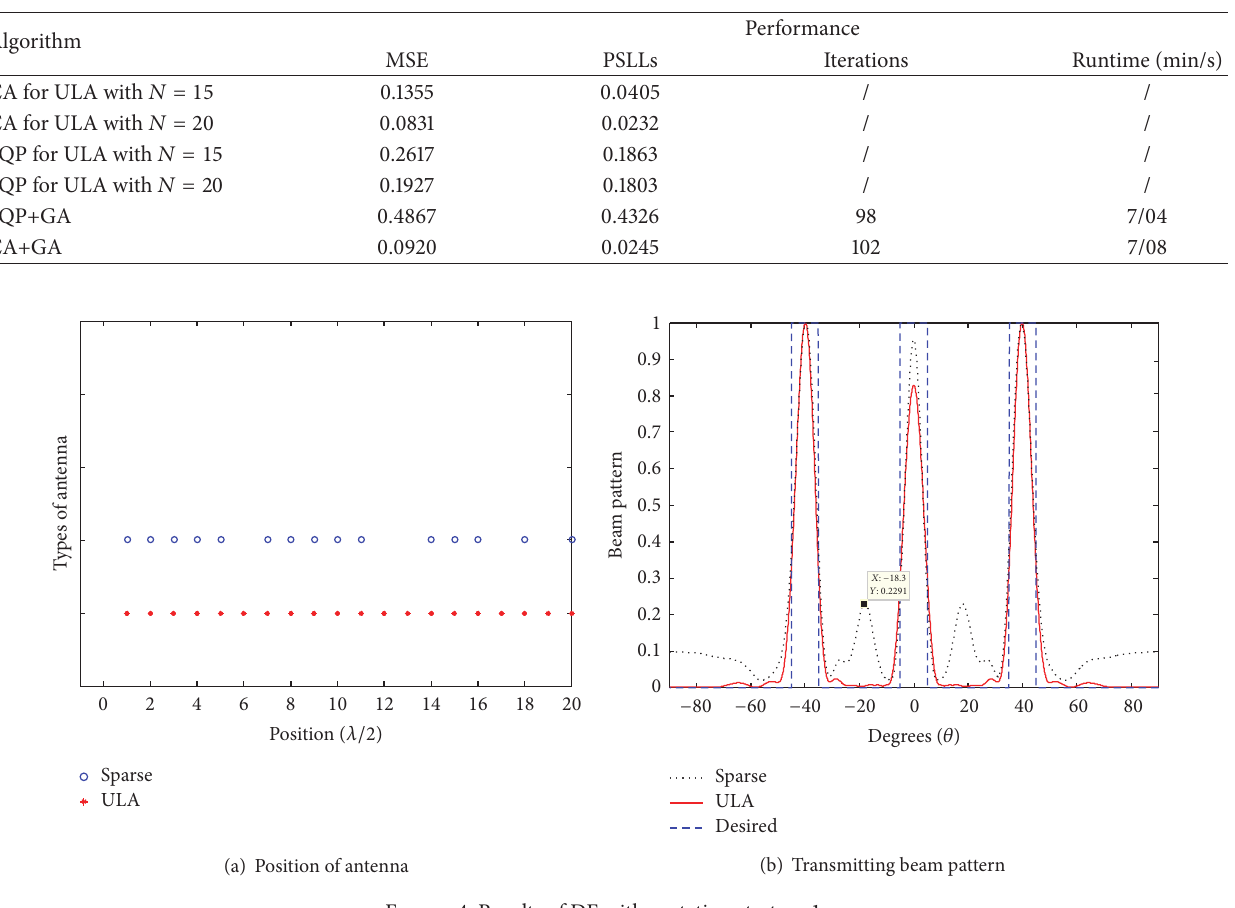
Table 1: Comparison of SQP and CA.